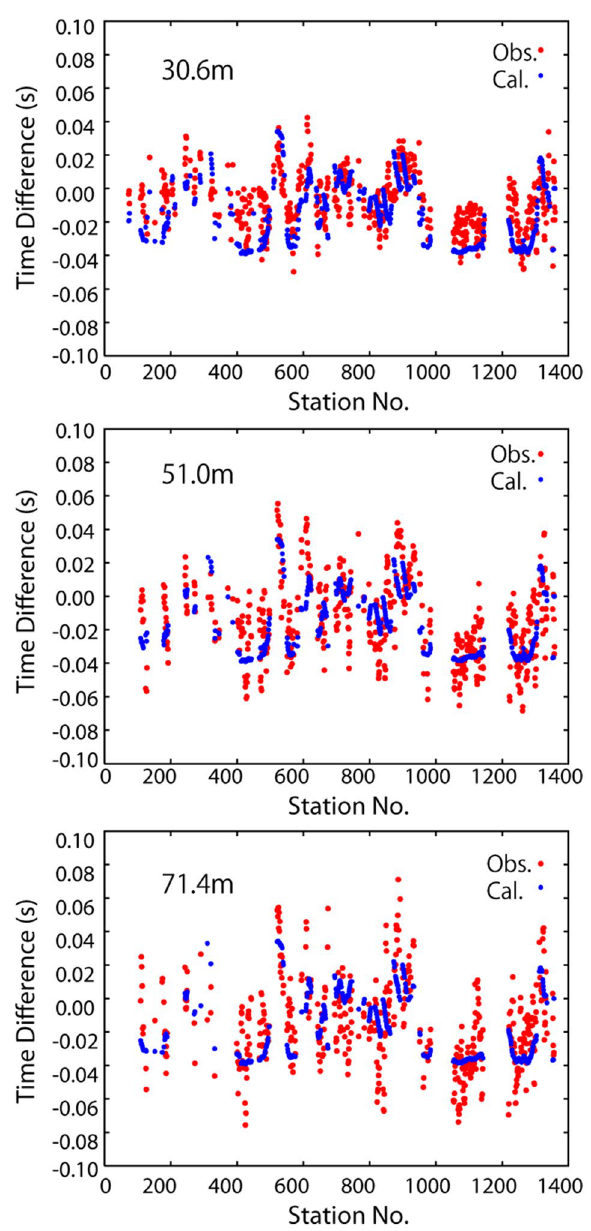
station numbers represent locations close to